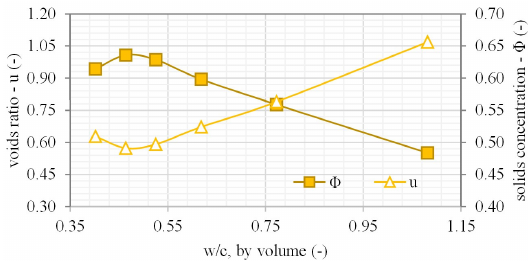
Figure 6. Void ratio and solids concentration of Portland cement